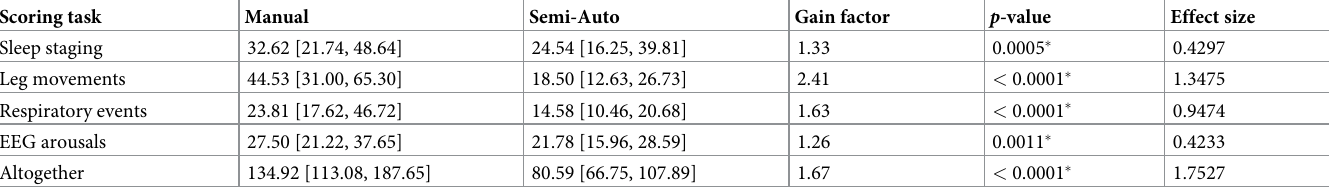
Table 2. Analysis of scoring time differences per task between manual and semi-automatic approaches. Scoring